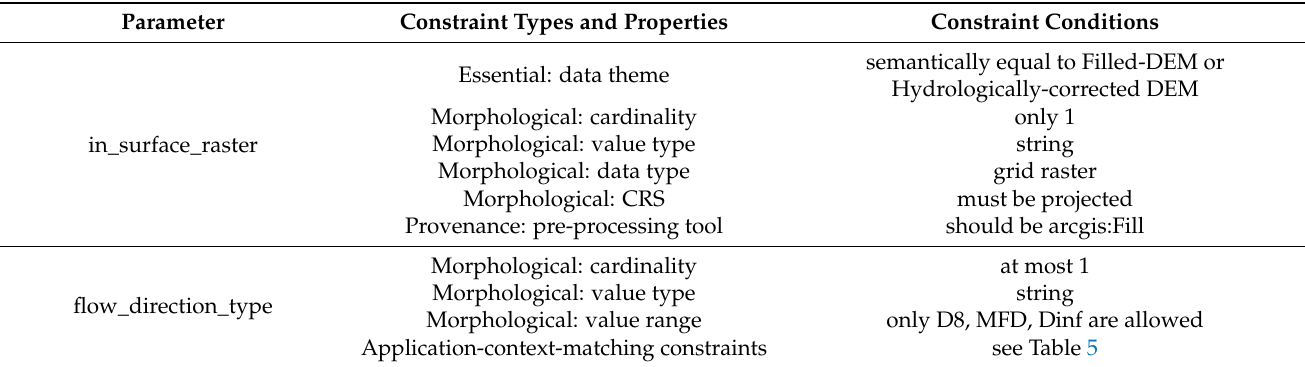
Table 5. Constraints of the parameter “in_surface_raster” and “flow_direction_type”.